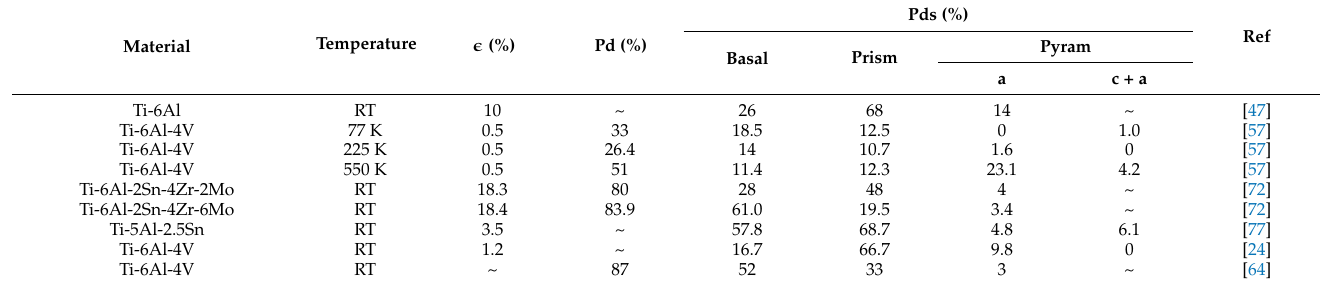
Table 3. Statistics on the proportion of slip-activated